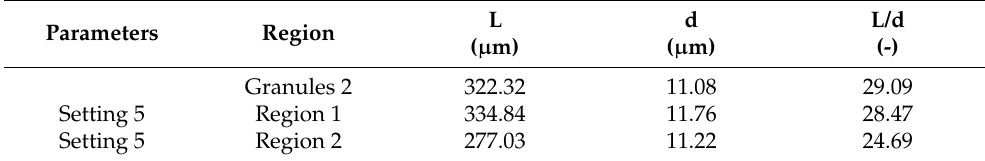
Table 9. Mean values of fiber length, diameter, and aspect ratio in granules and regions 1 and 2.